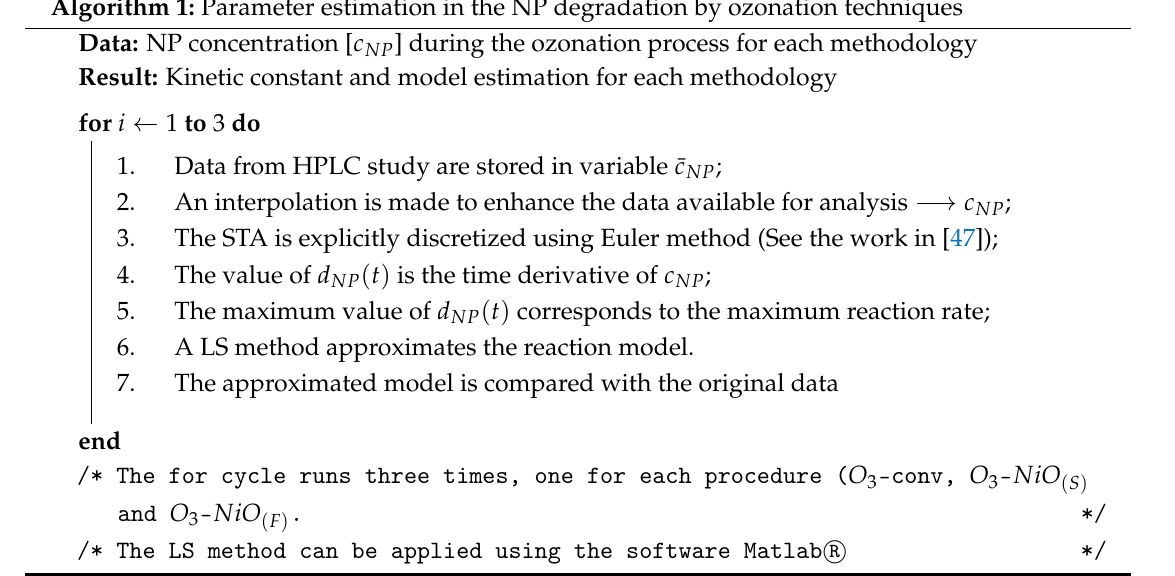
Algorithm 1: Parameter estimation in the NP degradation by ozonation techniques Data: NP concentration [ c NP ] during the ozonation process for each methodology Result: Kinetic constant and model estimation for each